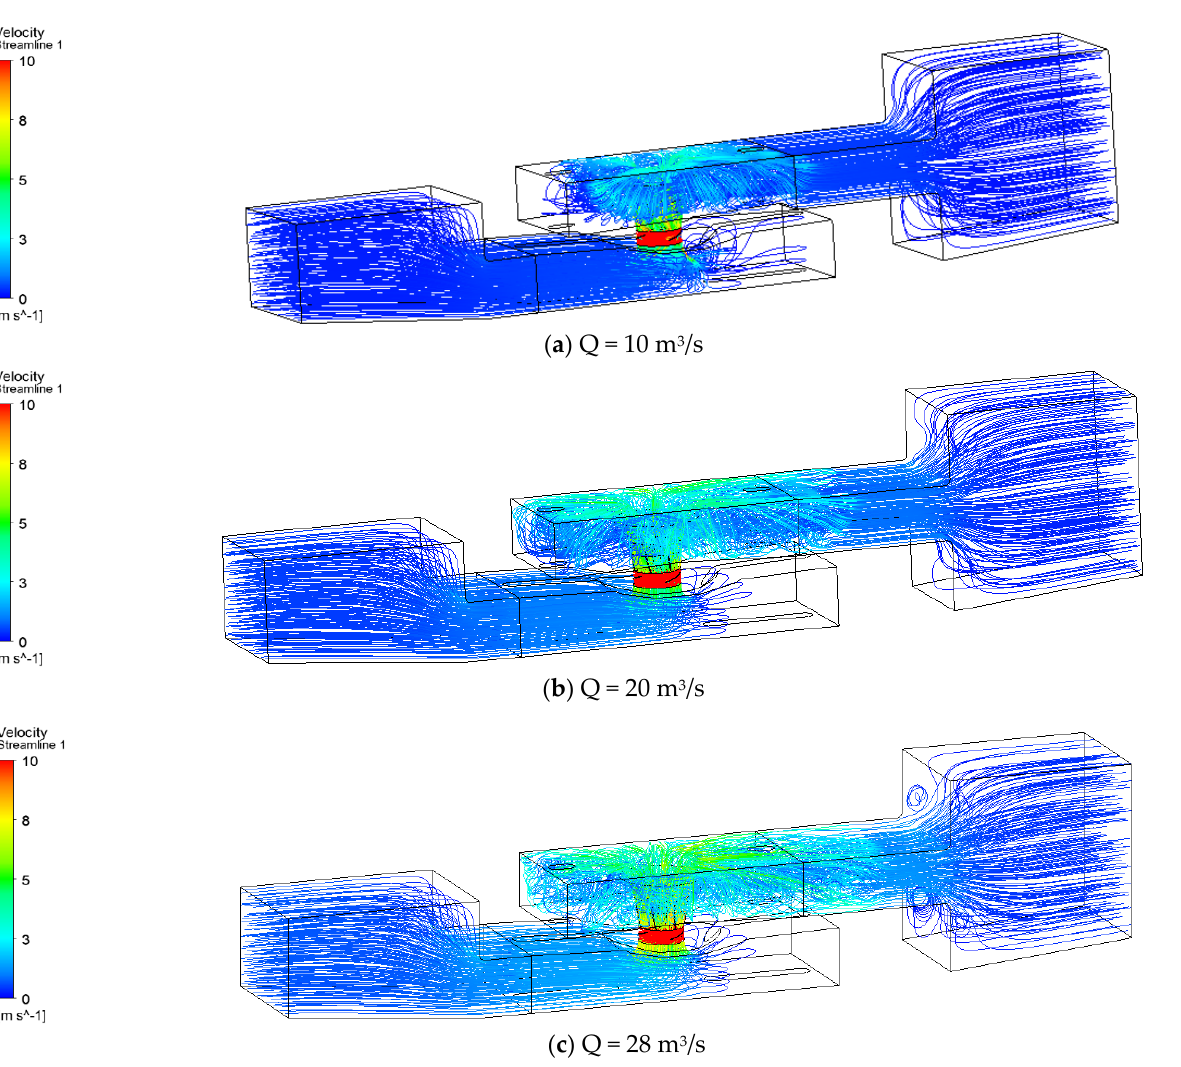
Figure 8. Numerical simulation and test hydraulic performance comparison.